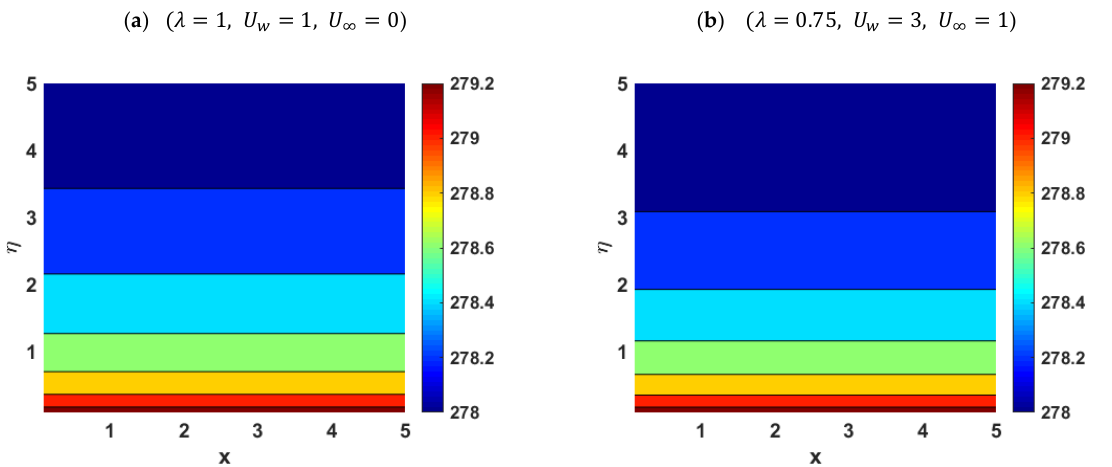
Figure 12. ( a , b ) Isotherms for m = 0.01, T ∞ = 278 K, ν ∞ = 8.91 × 10 − 7 , Pr = 6, θ w = 1.27 and (cid:101) = 5. Table 2. Numerical values of 𝑓 (cid:4593) ′(cid:4666) 0.1 (cid:4667) and 𝜃′(cid:4666) 0.1 (cid:4667) for different values of parameters when 𝑃𝑟 (cid:3404) 5 and 𝜃 (cid:3050) (cid:3404) 1.27 . Results are included for the exponential temperature dependency (case A) only. 𝝐 𝝀 𝒎 𝒇 (cid:4593)(cid:4593) (cid:4666)𝟎 . 𝟏(cid:4667) 𝜽 (0.1) 1